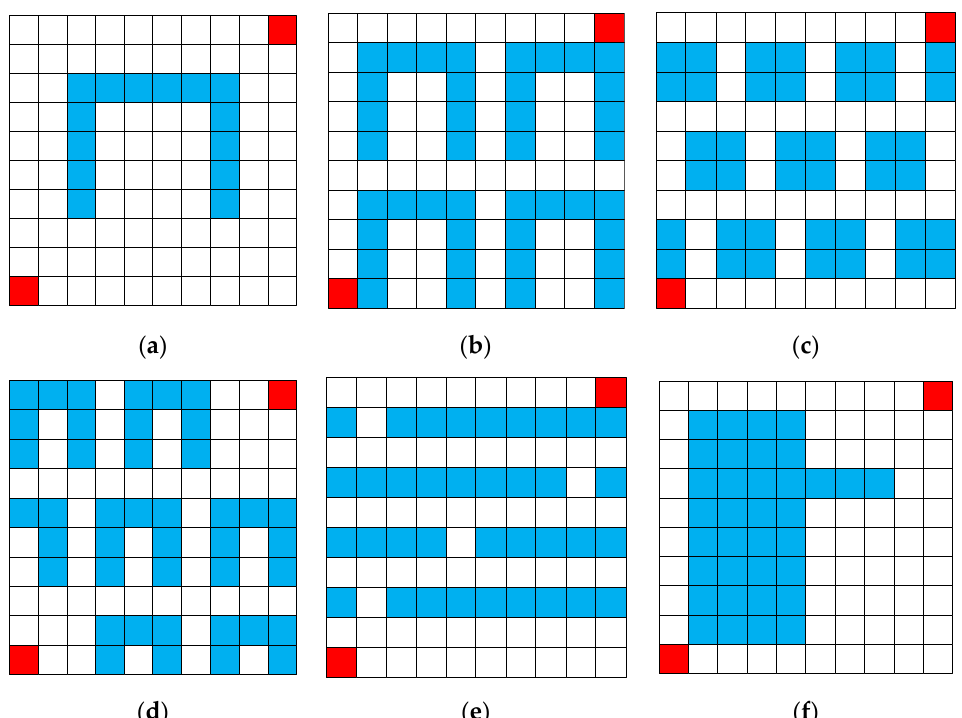
Figure 9. The experimental configuration of the 10 × 10 cells: ( a ) 10_1n; (b) 10_4n; ( c ) 10_11s; ( d ) 10_7n; ( e ) 10_4ch; and, ( f ) 10_1o.